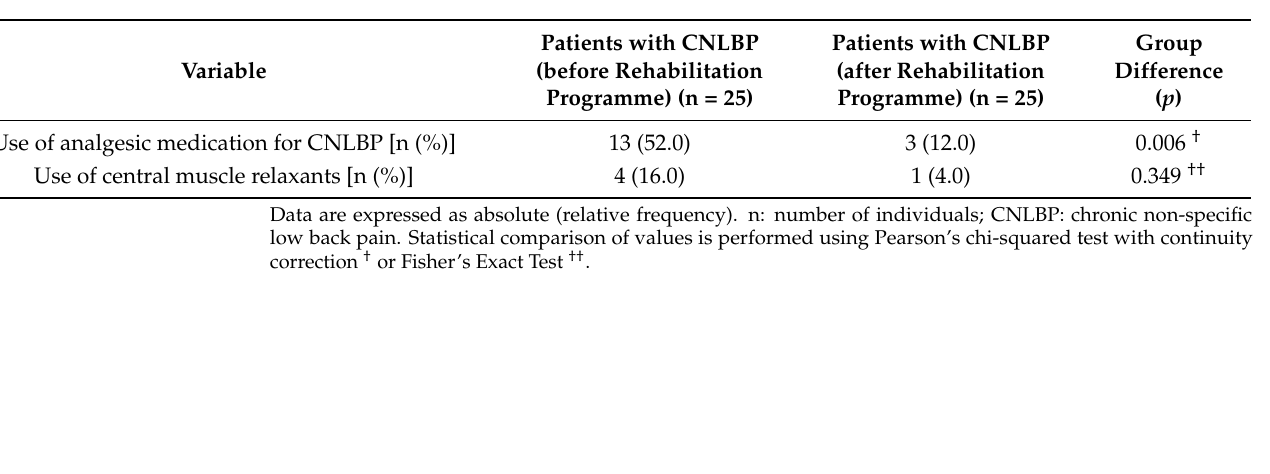
Table 5. Use of medication—before and after rehabilitation